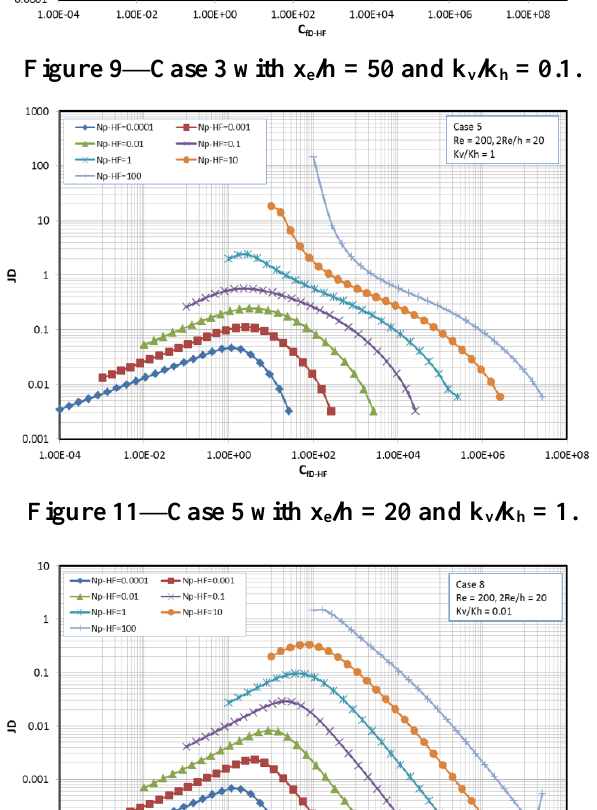
/k = 0.01. Figure 14—Case 9 with x v h